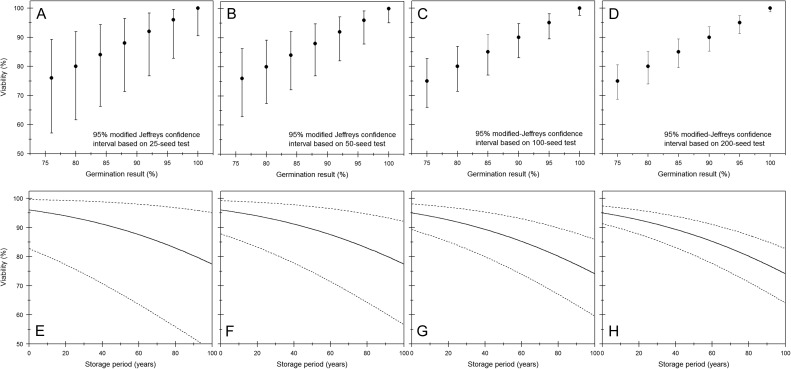
Confidence intervals give an indication of the reliability of a germination test result (proportion or percentage germination) as an estimate of the whole seed lot viability. (A–D) Ninety-five per cent modified Jeffrey's confidence intervals [Brown et al., 2001; calculated using EpiTools (AusVet Animal Health Services, 2016)] for sample sizes of 25, 50, 100 and 200 seeds and germination results ≥75%. (E–H) The predicted survival curves for rice seeds stored at 7% moisture content and 3°C with initial viability of 96 (E and F) or 95% (G and H) or the lower and upper limits of the 95% confidence intervals of these proportions for the corresponding sample size (as indicated in the upper graphs).